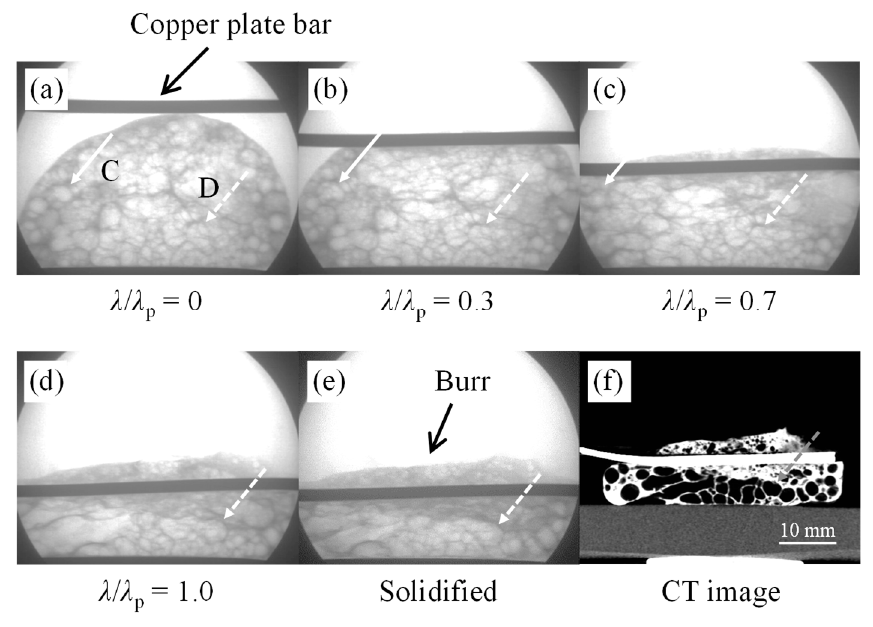
Figure 5. ( a – f ) X-ray transmission images of Sample II taken during press forming and X-ray CT image of obtained aluminum foam.